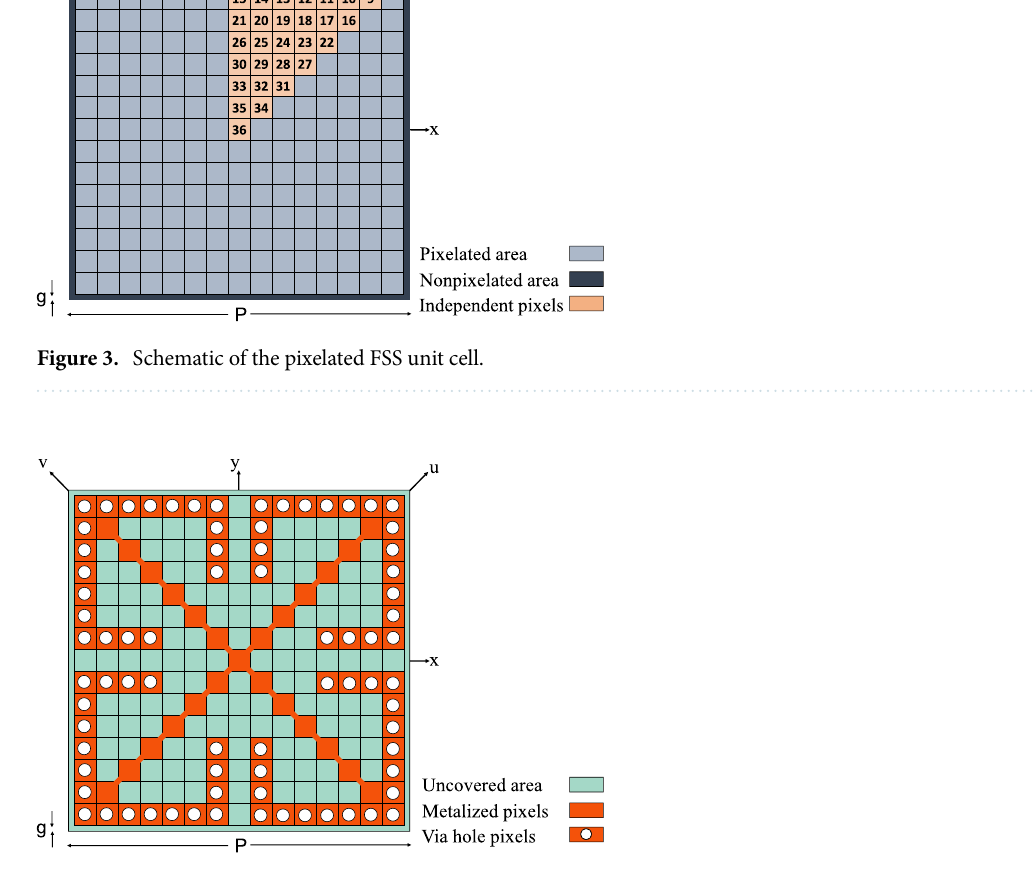
Figure 4. Schematic of the optimized FSS unit